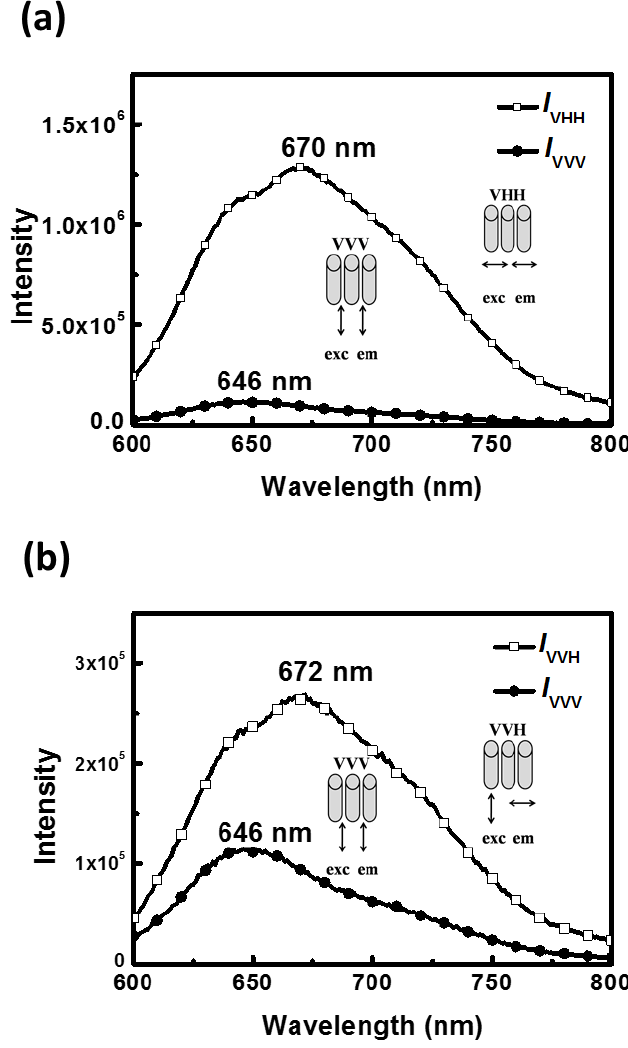
Figure 7. Polarized photoluminescence spectra of the aligned P3HT electrospun nanofibers prepared from the CF system with ( a ) the exciting light and the corresponding emission polarized in the perpendicular ( I VHH ) or parallel ( I VVV ) direction with respect to the fiber axis and ( b ) the exciting light polarized in the parallel direction with respect to the fiber axis, and the corresponding emission polarized in the perpendicular ( I VVH ) or parallel ( I VVV ) direction with respect to the fiber axis.